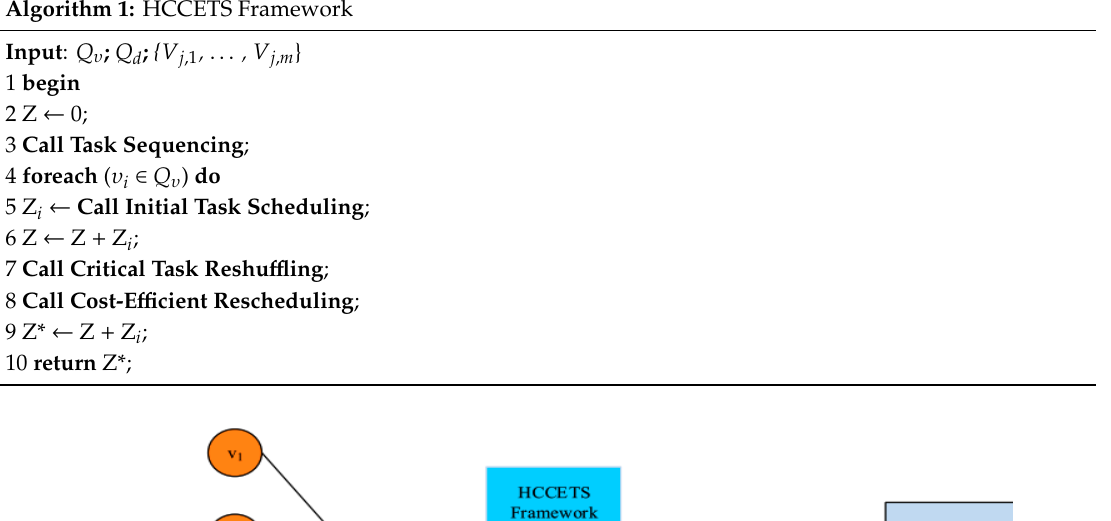
Algorithm 1: HCCETS Framework